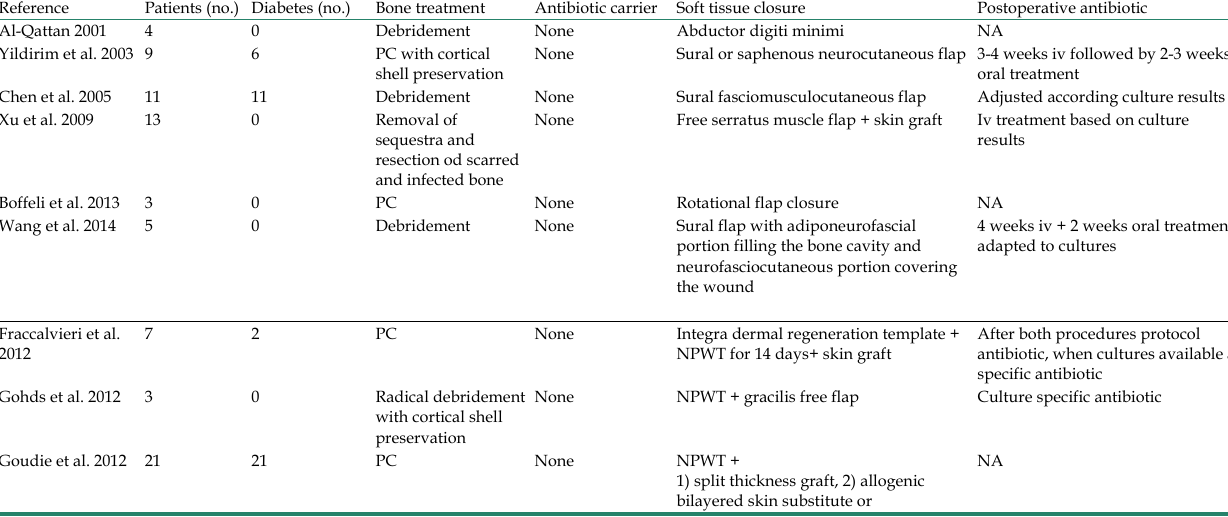
Table 4 : Systematic review of studies describing soft tissue treatment for calcaneal osteomyelitis. Results and follow up.